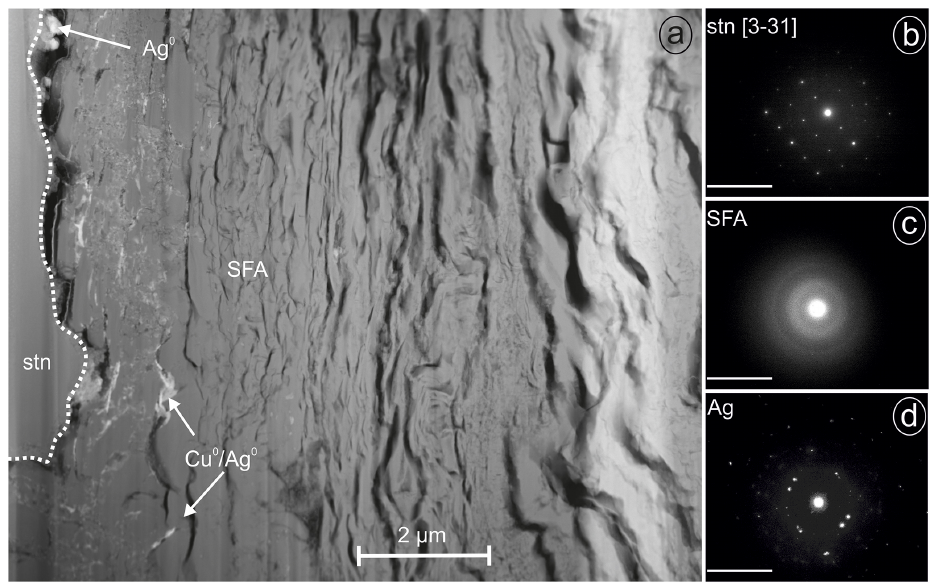
Figure 8. FIB lamella with SAED patterns (given in reciprocal lattice with 1 / 10nm − 1 scale) from Giftkies (Ag 0 , native silver; Cu 0 , native copper; SFA, amorphous Sn–Fe–As phase; stn, stannite): (a) lamella with stannite and a broad band of SFA and native metals, (b) SAED pattern of stannite, (c) SAED pattern of SFA, and (d) SAED pattern of native silver